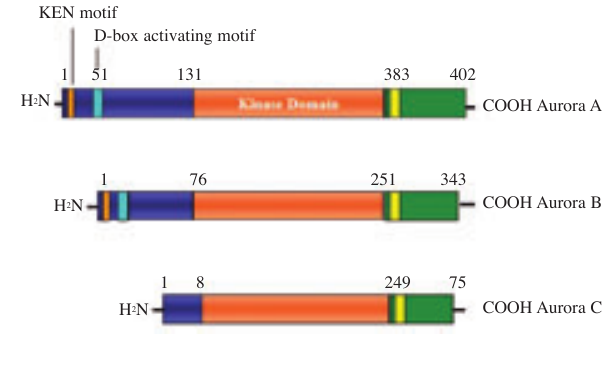
Figure 1. Schematic representation of domain organization of aurora kinases. Aurora kinases have three domains: the N-terminal and C-terminal domains which contain most of the aurora’s regulatory motifs and the catalytic domain in the central region. The align- ment of auroras A and B allows the identification of one distantly conserved ‘KEN’ motif, spanning 11-18 residues. The ‘KEN’ motif acts as a Cdh – dependant anaphase-promoting complex recognition signal.